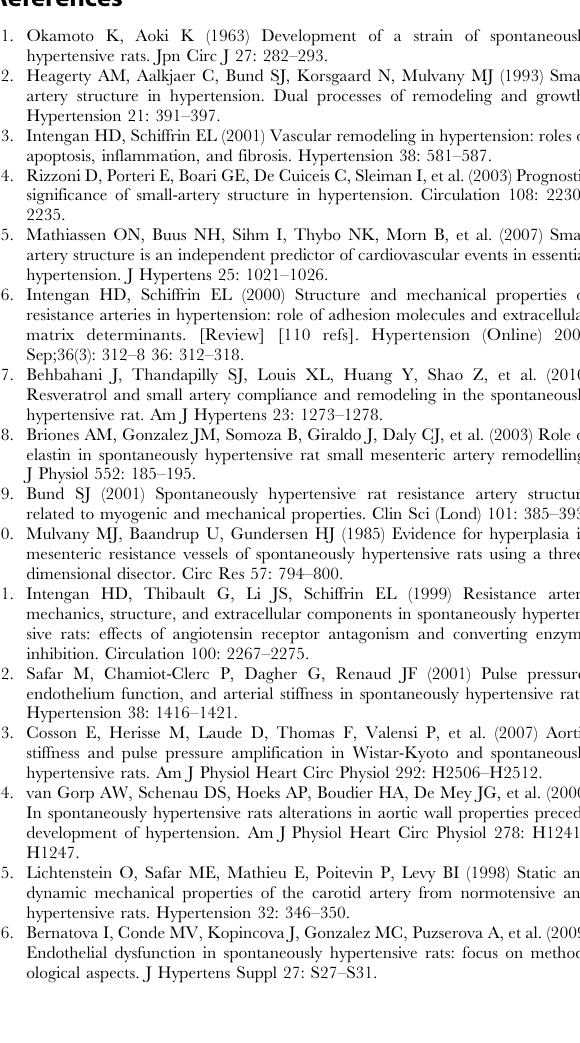
Figure S1 Vascular distensibility in WKY and SHR sublines. Figure S2 Aortic mechanical properties and dimen-